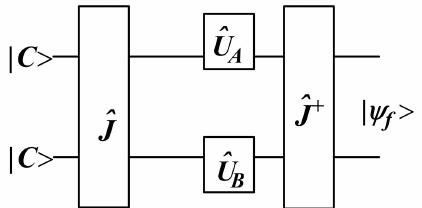
Figure 1. Schematic diagram of the quantum game calculation. (Note: this schematic diagram is mainly referred to Eisert et al.